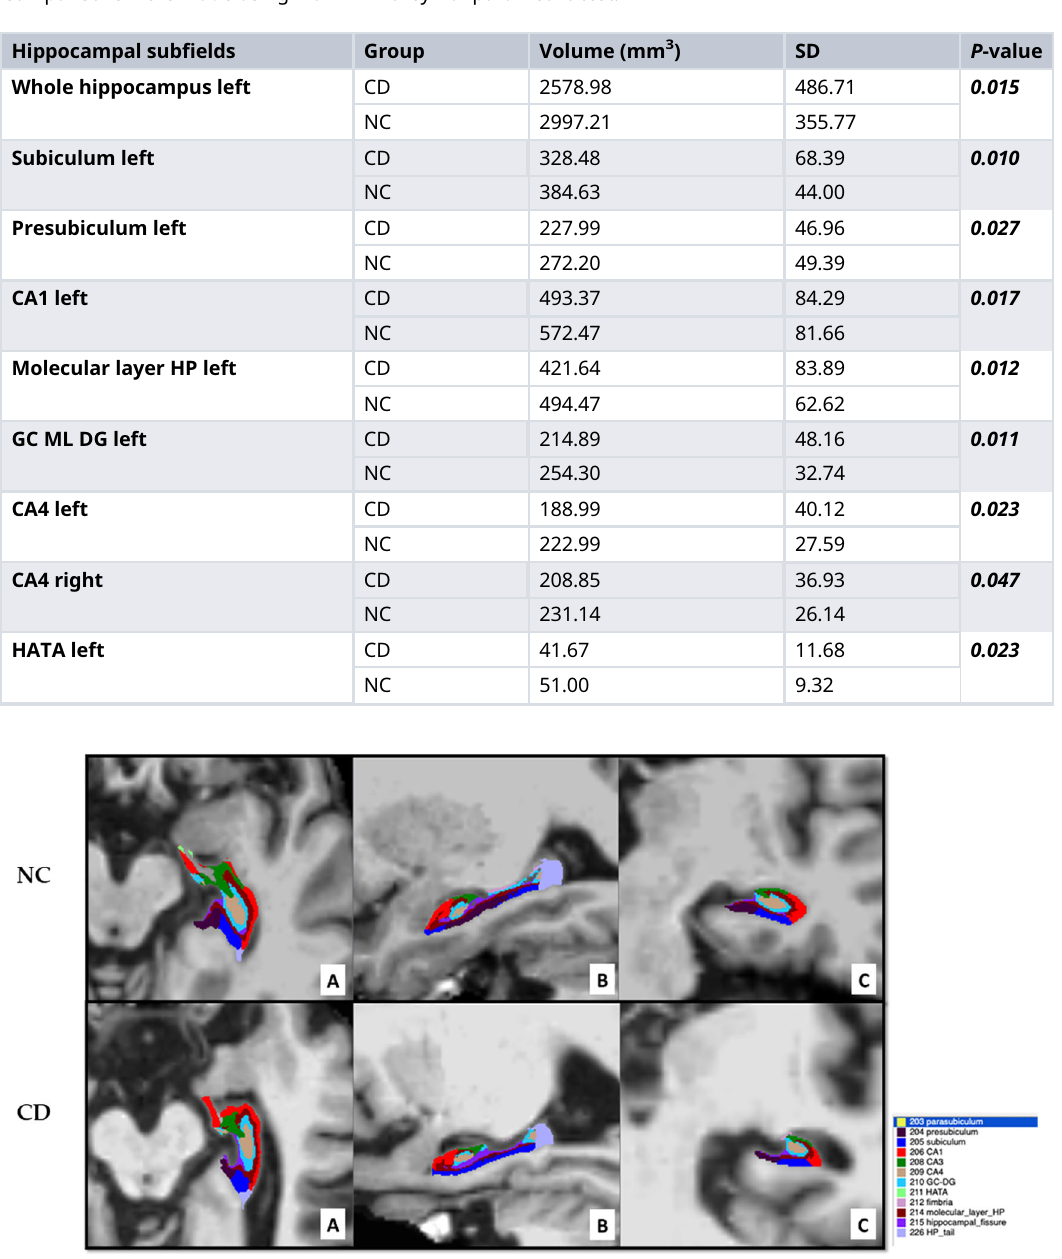
Figure 1. MRIscans ofthe hippocampus segmentation fora representative NC individual withanMMSE value of 30 (upper panel) and a representative CD patient with an adjMMSE value of 17.9 (lower panel): axial (A), sagittal (B) and coronal (C) view.